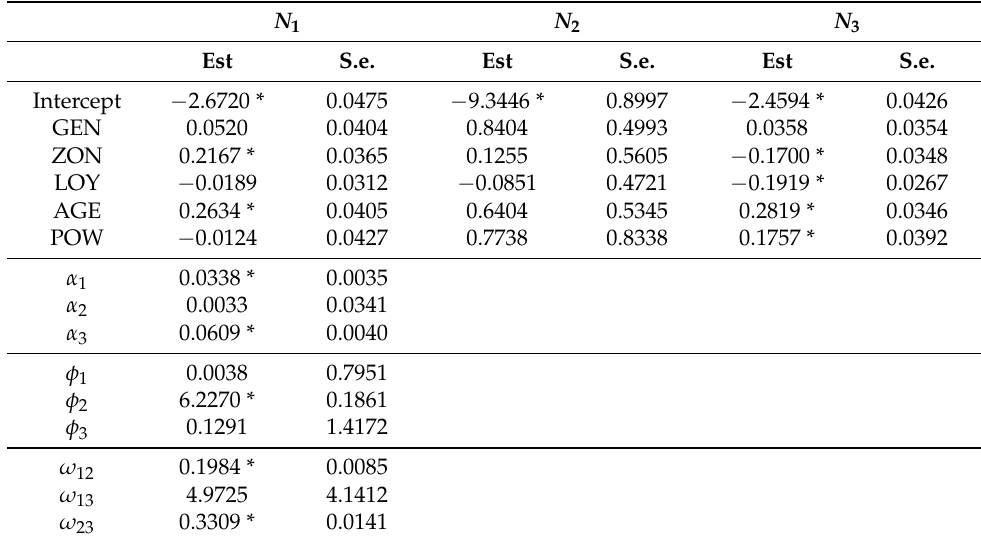
Table 3. Estimated parameters based on the trivariate INAR(1) models with 3-variate negative binomial innovation distribution. An * next to the estimated coefficient values implies significance at a level of